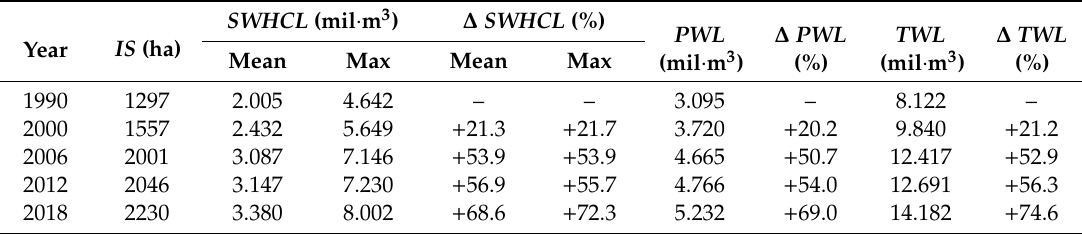
Table 7. Change of water retention potential during 1990–2018, the Pr ˛adnik river